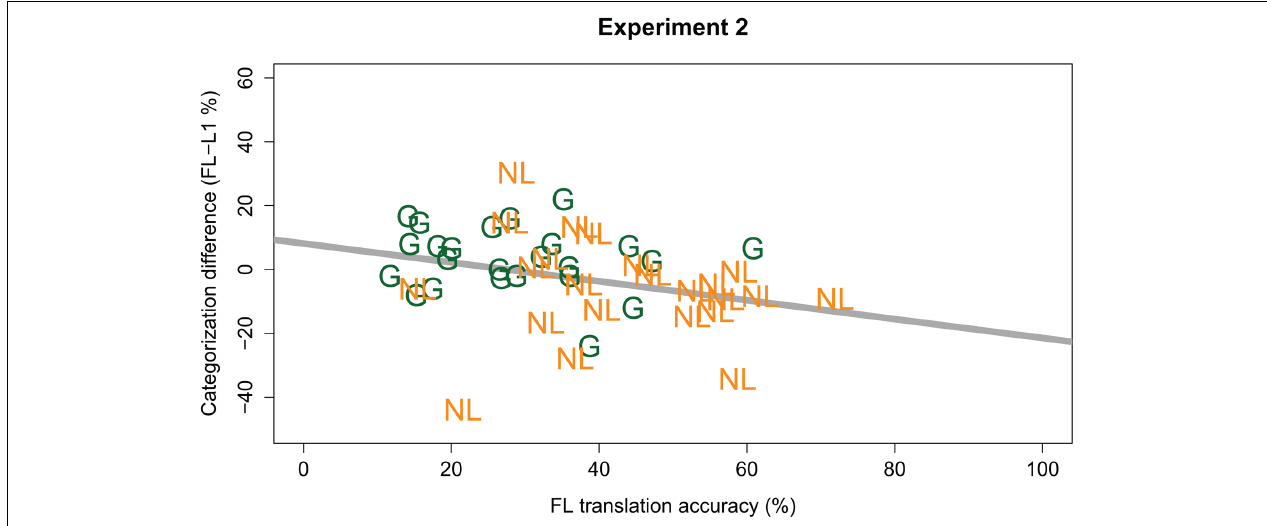
FIGURE 4 | Individual participants’ FL effect (y-axis; calculated as % /a:/ responses in FL minus L1; positive values indicate a higher percentage /a:/ responses in the FL) plotted against individual participants’ translation accuracy (x-axis; in % keywords correct) in the FL. German participants are indicated by green “G”; Dutch participants by orange “NL.” The bold gray line gives the regression line for the combined data from both